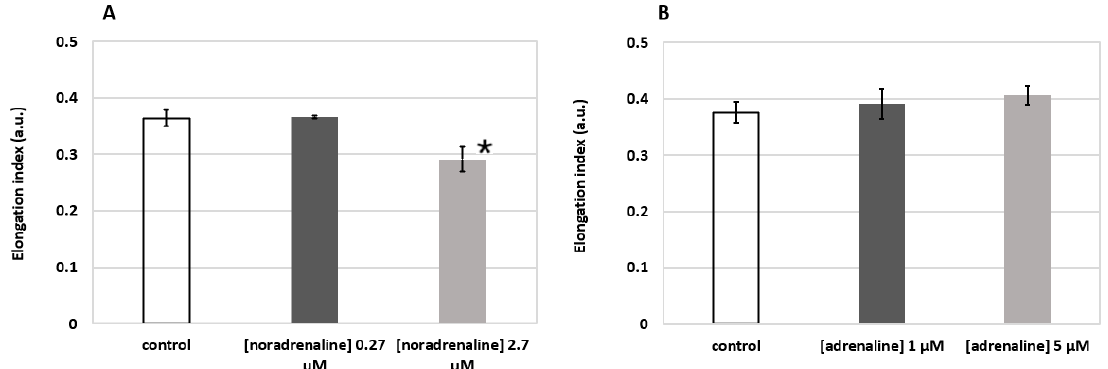
Figure 8. Changes in RBC deformability induced by metabolic hormones noradrenaline ( A ) and adrenaline ( B ) assessed by laser diffractometry using RheoScan AnD-300. Incubation time 15 min at 37 °C. Elongation index refers to the elongation of RBCs when 3 Pa external shear stress is applied. Blood was from a healthy male individual. Measurements were performed three times; bars represent mean values; error bars designate standard deviations; * p < 0.05 ( t -test).